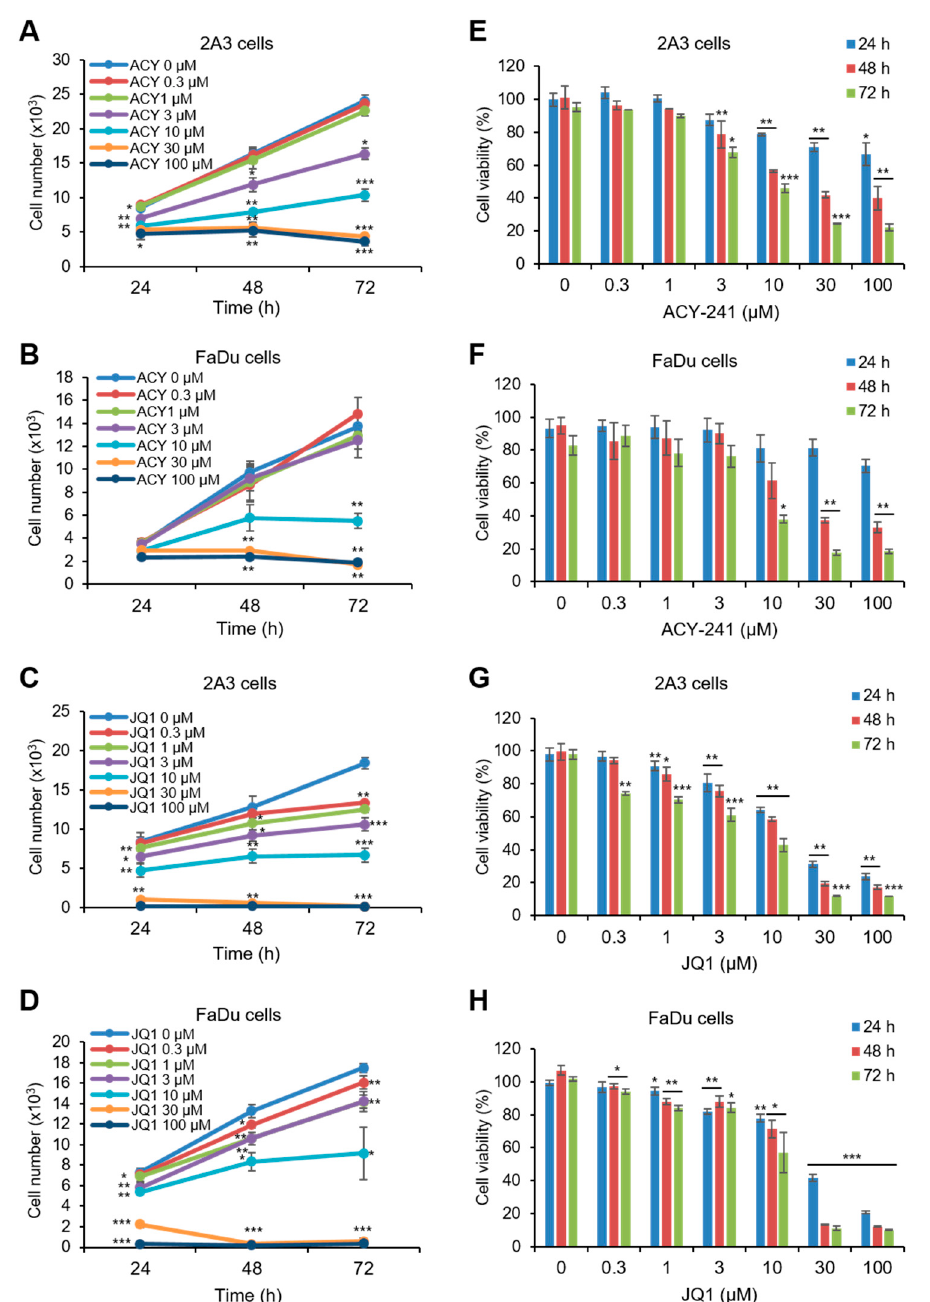
Figure 1. Single treatments of ACY-241 and JQ1 time- and dose-dependently suppress cell growth and reduce cell viability in both human papillomavirus (HPV)-positive and HPV-negative head and neck squamous carcinoma (HNSCC) cells. ( A , E ) 2A3 cells and ( B , F ) FaDu cells were treated with 0.1% DMSO or ACY-241 at indicated concentrations for 24–72 h. ( C , G ) 2A3 cells and ( D , H ) FaDu cells were treated with 0.1% DMSO or JQ1 at indicated concentrations for 24–72 h. CCK-8 assay was performed to measure cell growth ( A – D ) and viability ( E – H ). Values represent mean ± SD from three independent experiments ( n = 3). * p < 0.05, ** p < 0.01, or *** p < 0.001 vs. DMSO control.